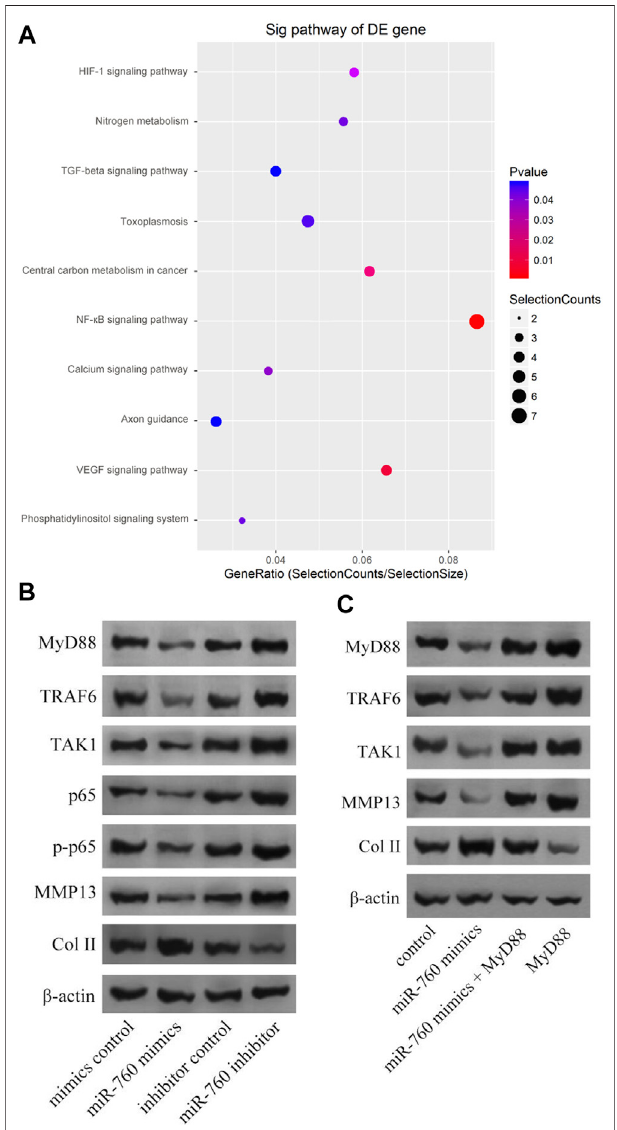
FIGURE 4 | MiR-760 exerted its functions by targeting the MyD88/ κ B signaling pathway. (A) KEGG analysis demonstrated that NF- κ B signaling pathway enriched in IDD. (B) Cultured primary normal human NP cells were transfected with miR-760 mimics, miR-760 inhibitor, their negative controlandthenthelevelsofMyD88,TRAF6,TAK1, p65,p-p65,MMP13and Col II were measured by western blotting. n = 3 replicates per group. (C) The rescue experiments were performed in cultured primary human NP cells to validate the relationship between miR-760 and MyD88. Inhibition of TRAF6, TAK1 and MMP13 expression levels by miR-760 mimics was rescued by restorationofMyD88expression. Incomparison,inhibitionofColIIexpression levels by MyD88 overexpression was rescued by miR-760 mimics. n = 3 replicates per group.